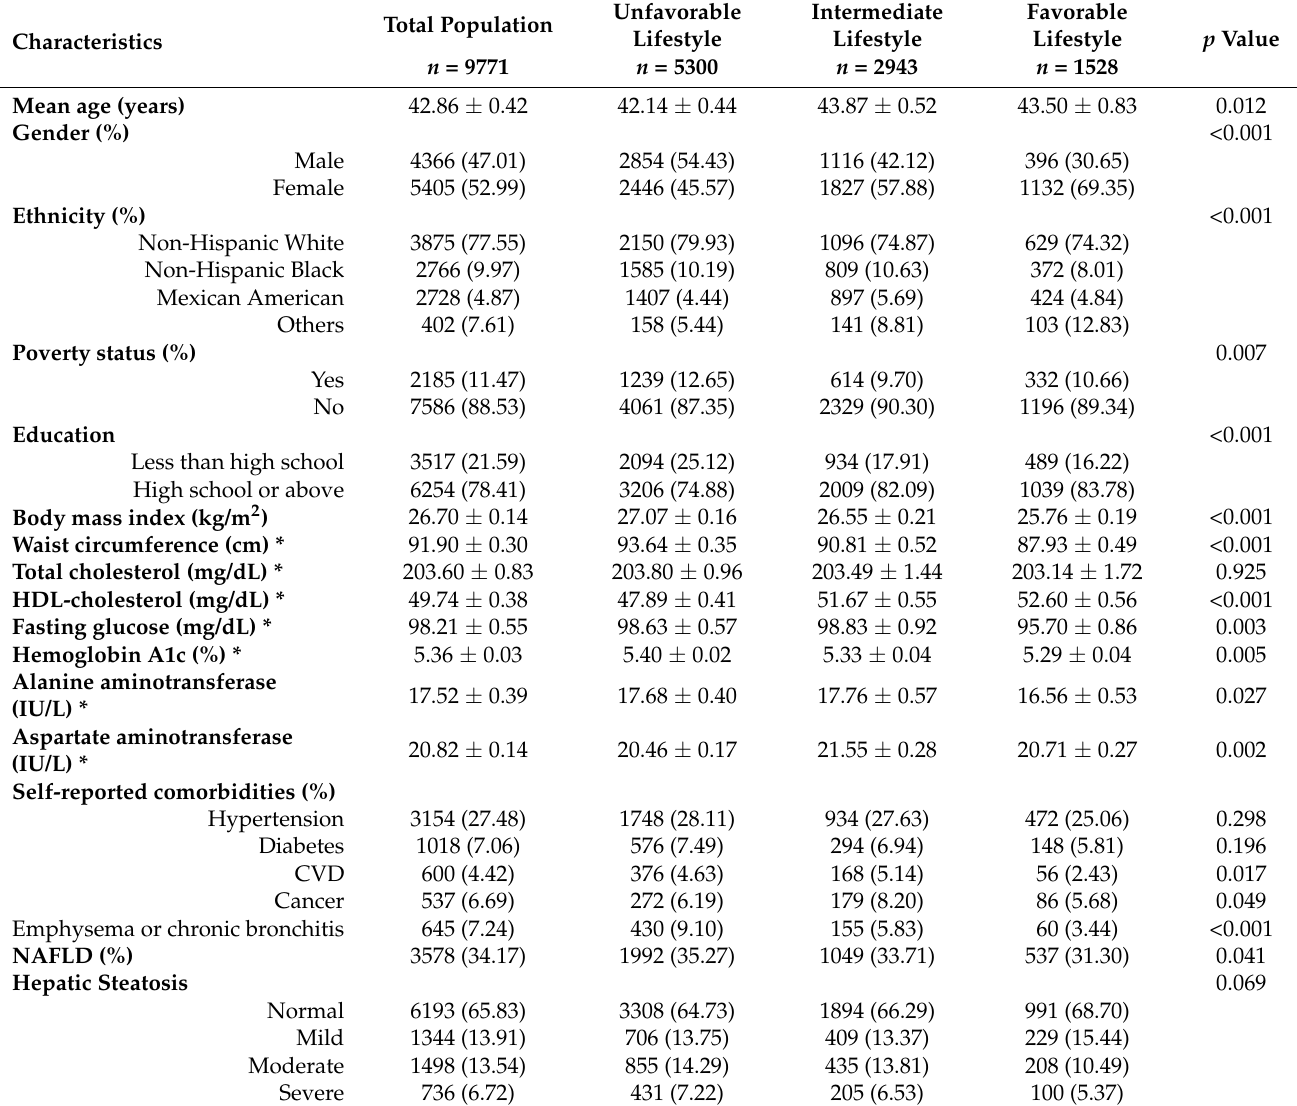
Table 1. Baseline characteristics of the study population according to healthy lifestyle